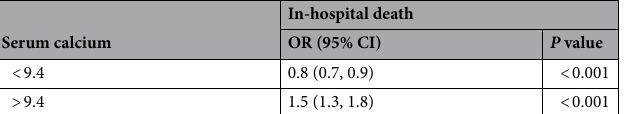
Table 4. Threshold effect analysis of serum calcium on in-hospital mortality. Adjust for: age, sex; BMI; chronic renal insufficiency; COPD; diabetes mellitus; stroke; history of malignancy; hemoglobin; lipid-lowering drugs; antiplatelet; anticoagulants; nitroglycerin.